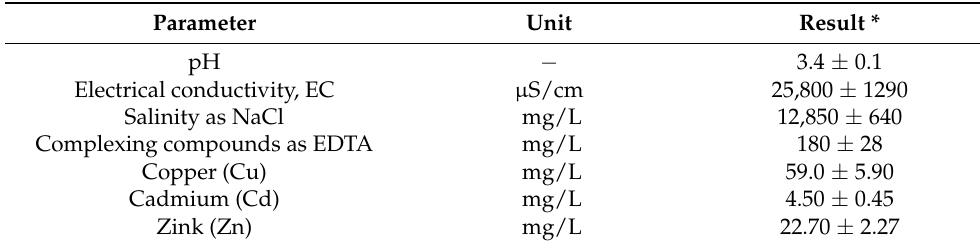
Table 3. Determined physicochemical parameters of real galvanic